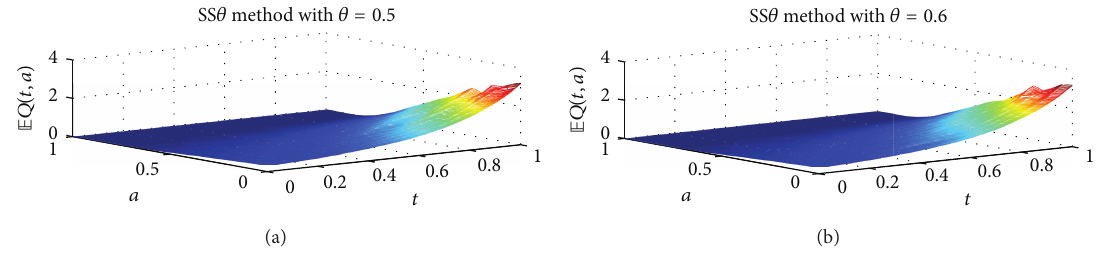
Figure 3: Expectation of numerical solution with 1000 tests, where Δ = 0.005 and Δ𝑎 = 0.05